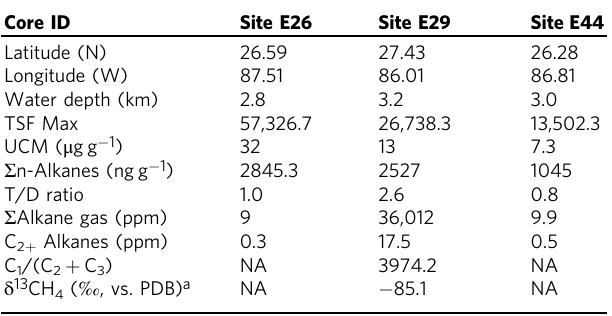
Table 1 Geochemical description of sediment samples from Sites E26, E29, and E44